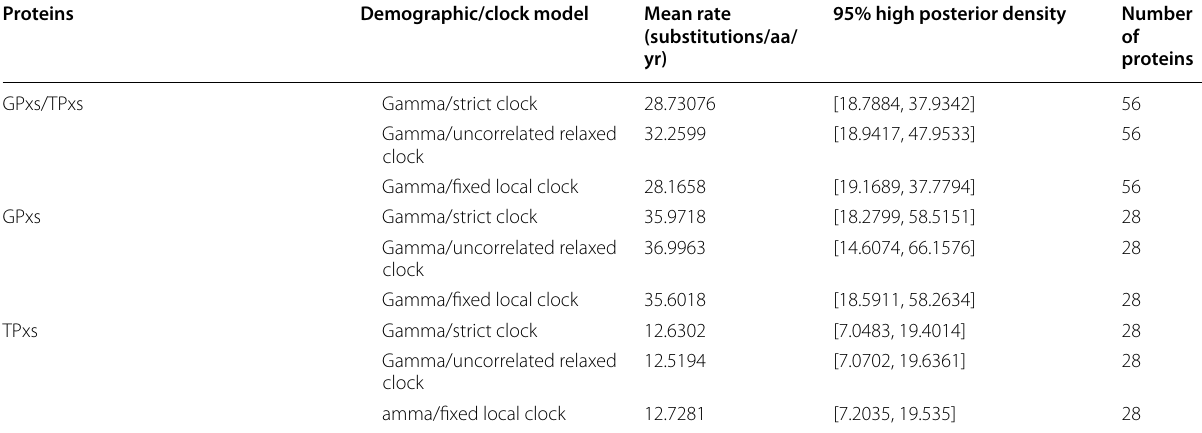
Three clock models (the strict, uncorrelated relax and fixed local clock) were used for estimating evolutionary rate aa amino